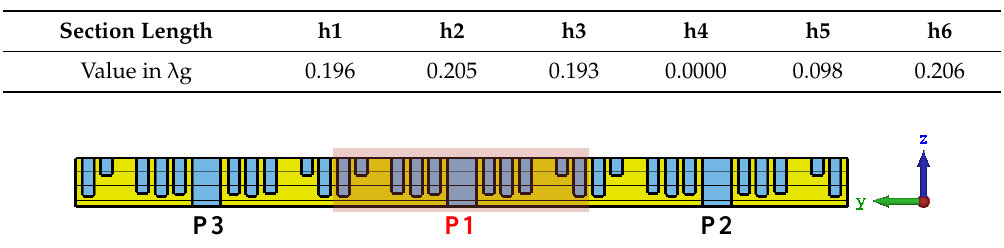
Table 1. Passive waveguides lengths of the optimized structure.